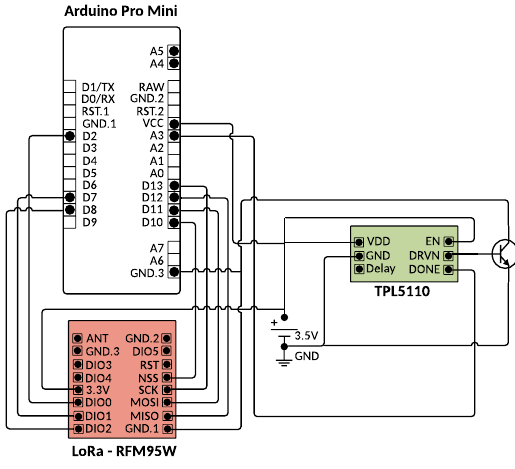
Figure 5. Scheme of LoRaWAN parking beacon